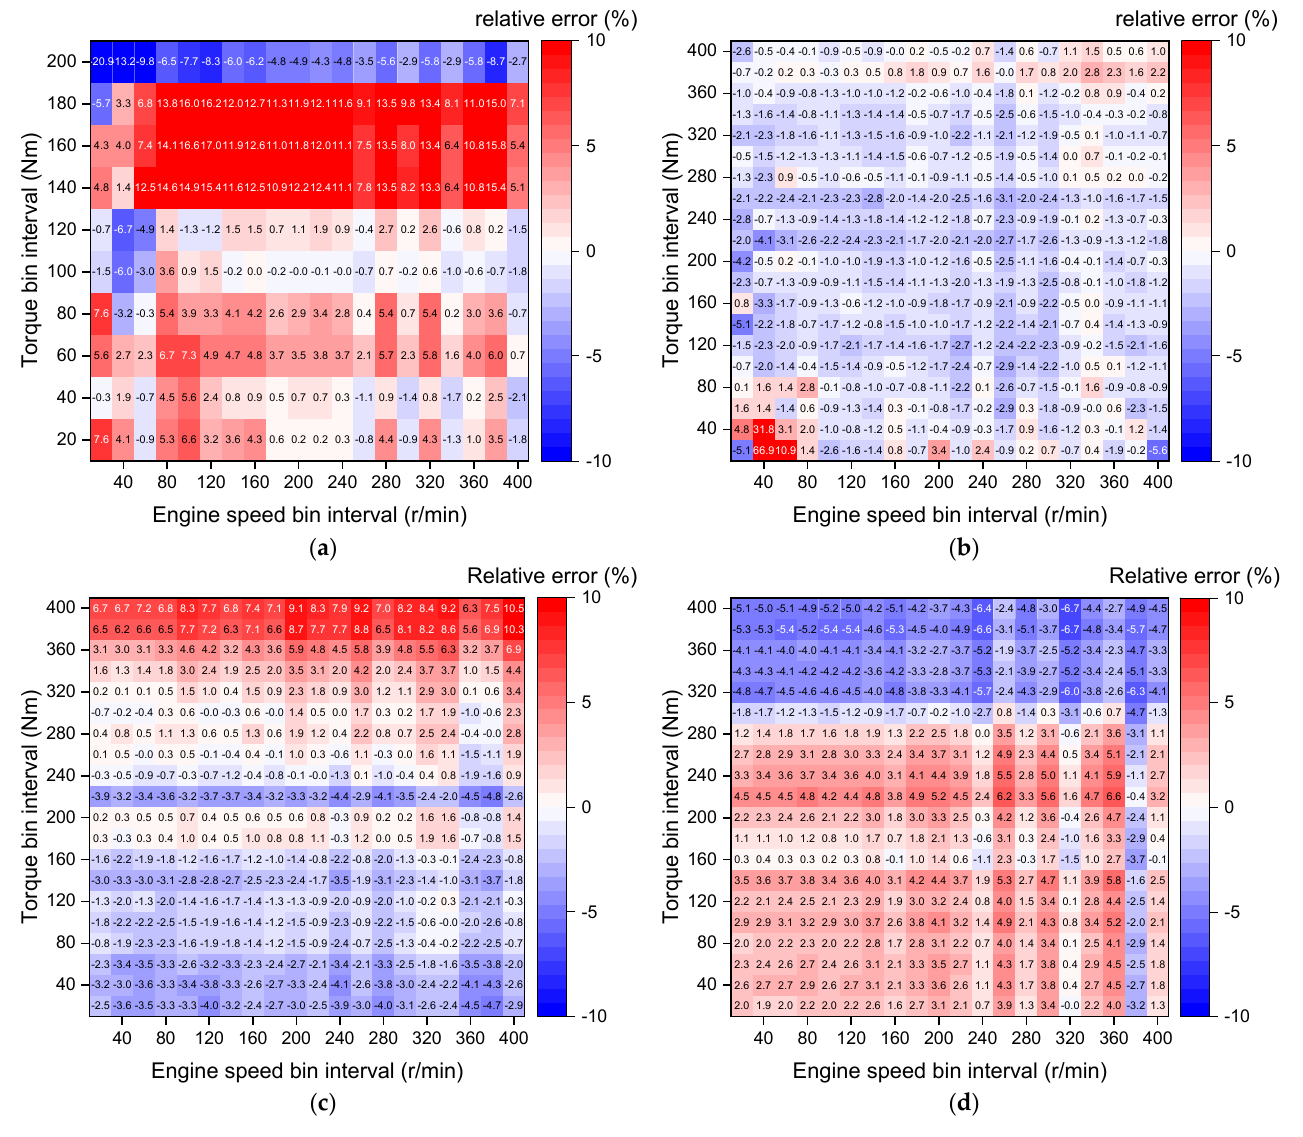
Figure 8. Effects of the binning interval (2D fitting). ( a ) Vehicle one. ( b ) Vehicle two. ( c ) Vehicle three. ( d ) Vehicle four.